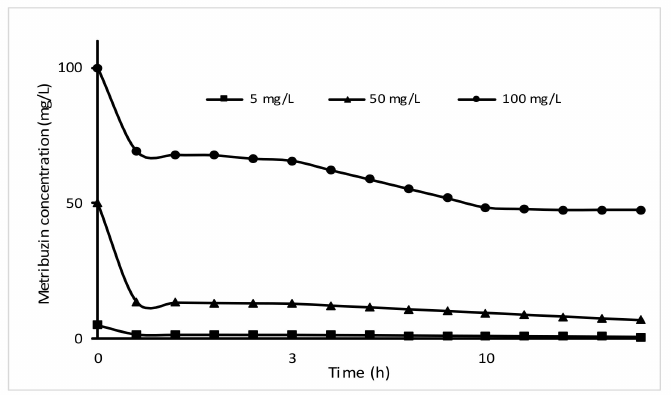
Figure 4. Influence of initial metribuzin concentration on WSB adsorption.